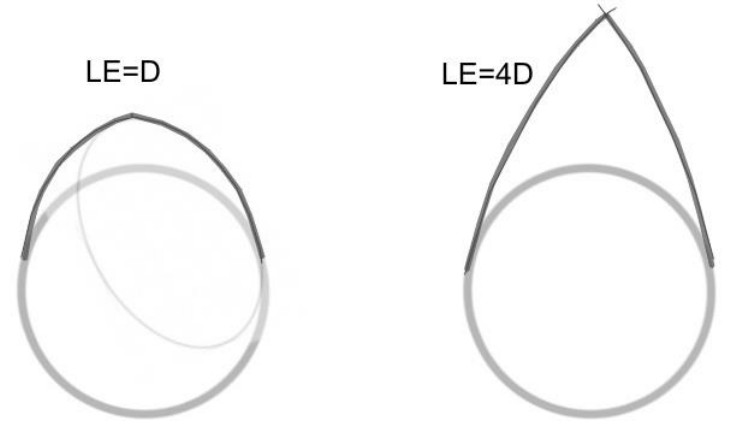
Figure 17. Bifaces formed with points based on LE=D and